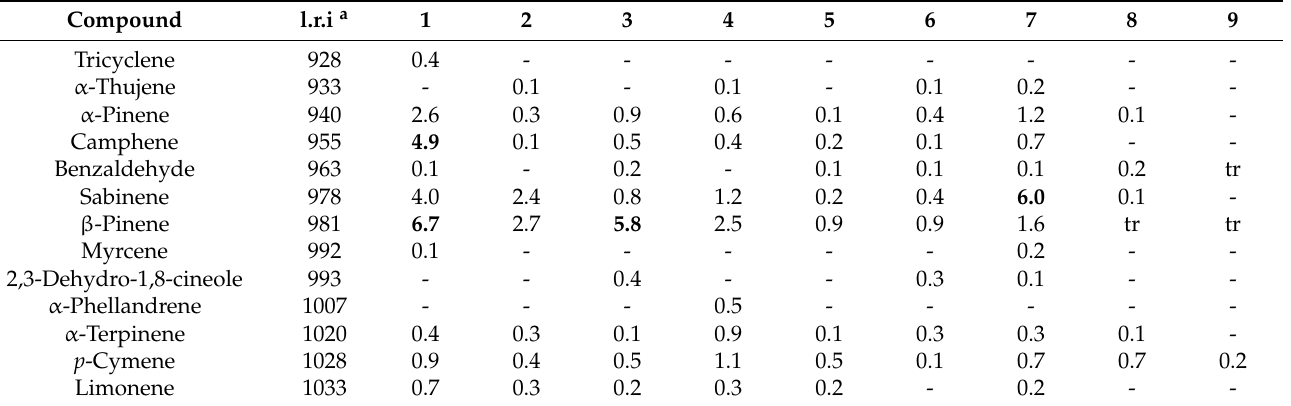
Table 2. Compositions of the flowers EOs obtained from the eight wild samples of Achillea ligustica (1–8) and a cultivated one